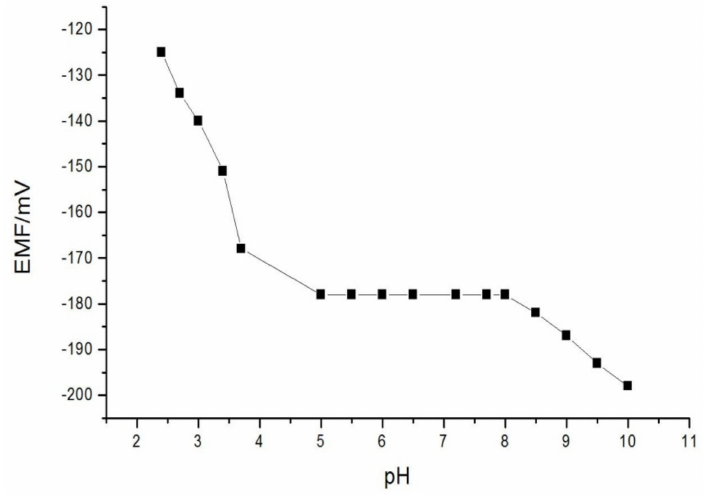
Figure 3. Influence of the developed electrode restraint on the pH in [10 − 3 M] aluminum ion concentration.